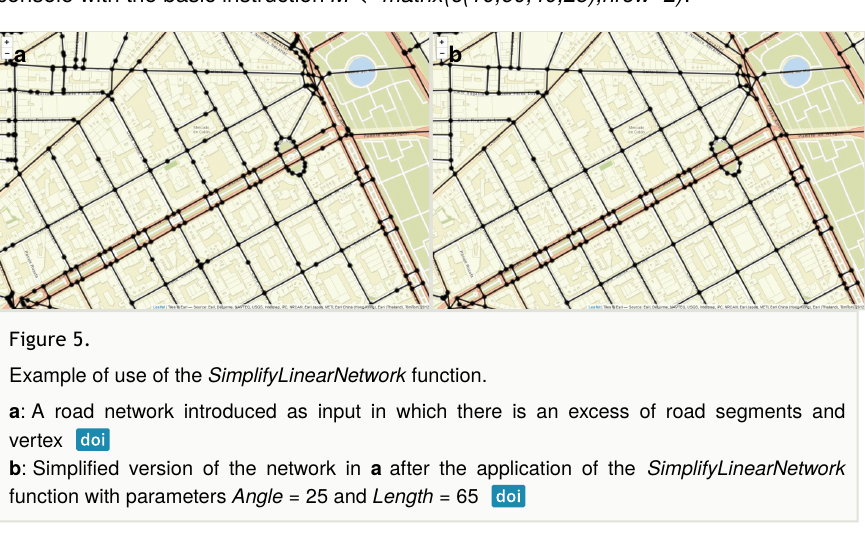
Example of use of the SimplifyLinearNetwork